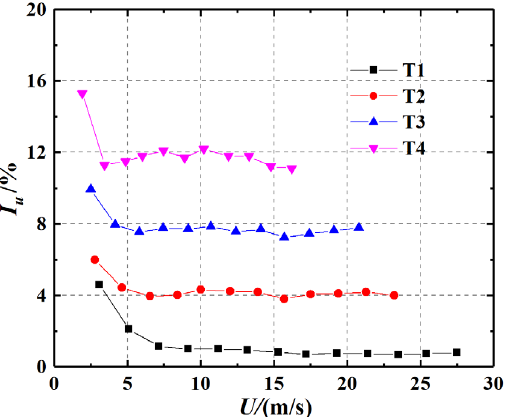
Figure 4. The relationship between wind speed and turbulence intensity on the surface of the platform center.